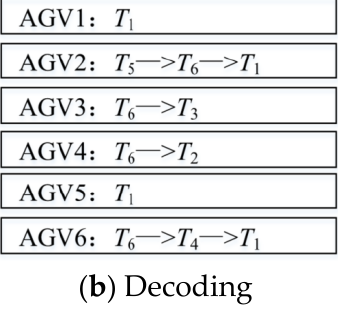
Figure 3. An example of coding and decoding.